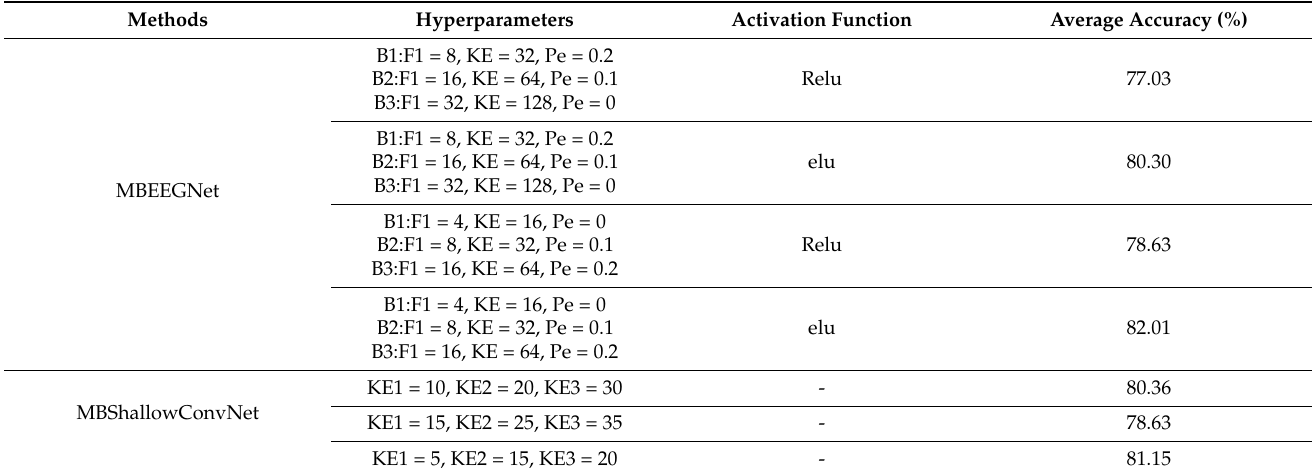
Table 6. Accuracy for proposed models at different parameter combinations.